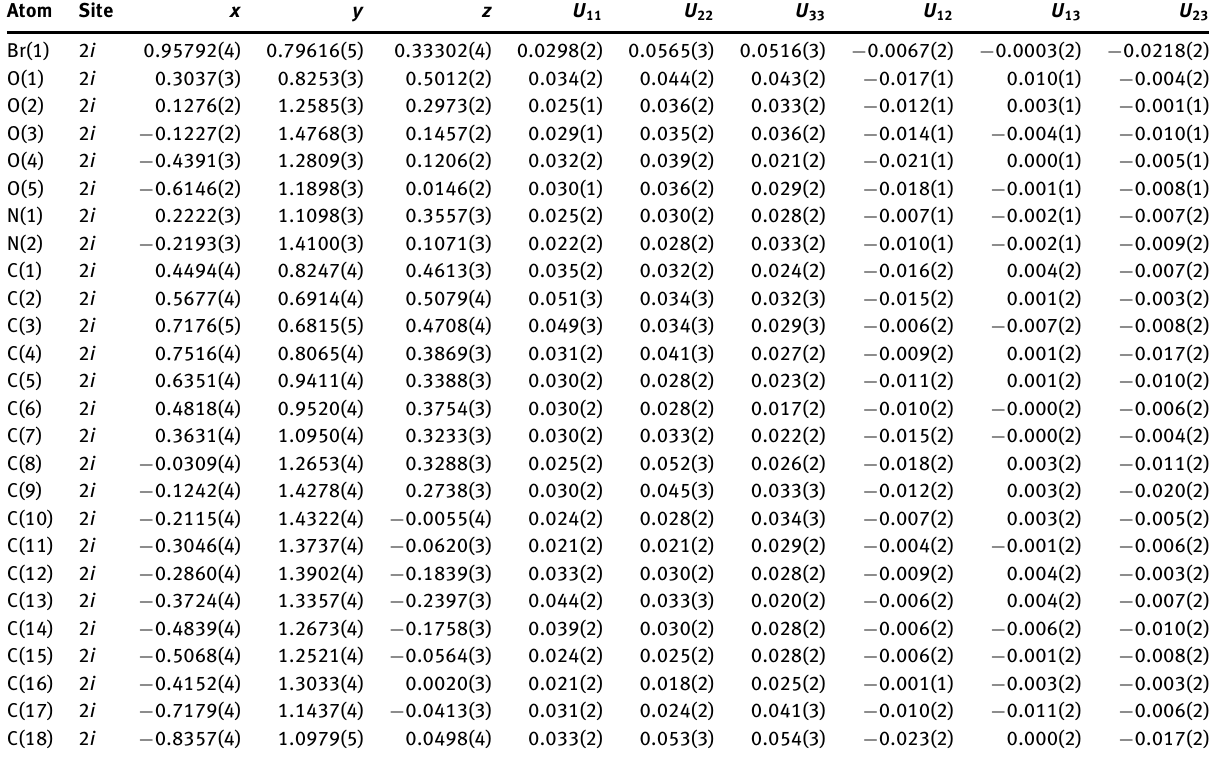
Table 3: Fractional coordinates and atomic displacement parameters (Å 2